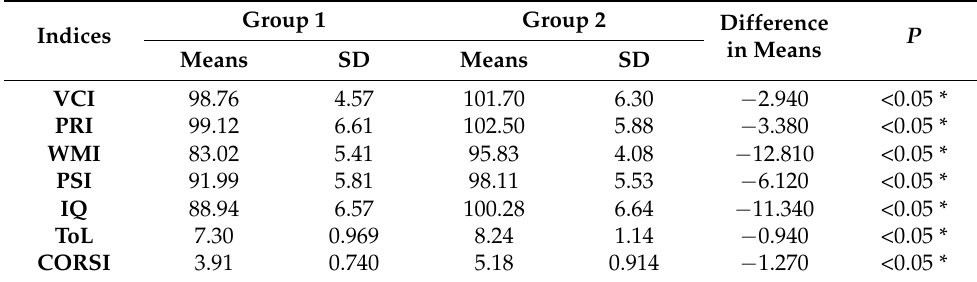
Table 4. Post hoc comparisons between group 1 and